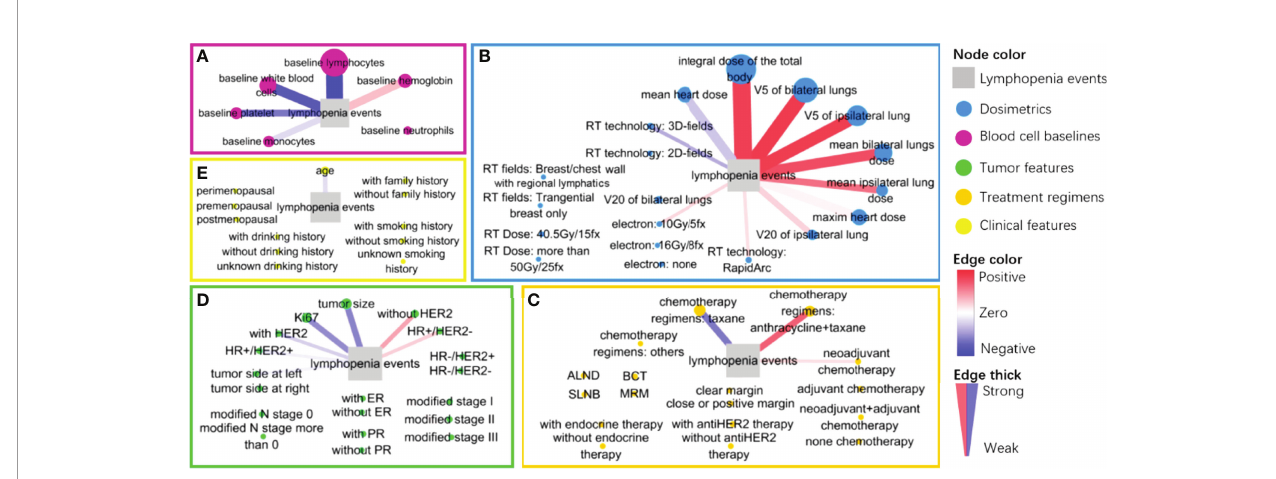
FIGURE 3 | The graphic layout of directional SHAP values of each feature classi fi ed in fi ve feature groups: (A) baseline blood cells group (maroon), (B) radiation dose group (blue), (C) treatment regimens group (Khaki), (D) tumor characteristics group (green) and (E) clinical characteristics group (yellow). The event of lymphopenia is a gray square. Each feature node is colored by group and sized by the SHAP values; each edge is colored from red (positive) to blue (negative) by the direction value of SHAP and its thickness is sized by the absolute direction values of